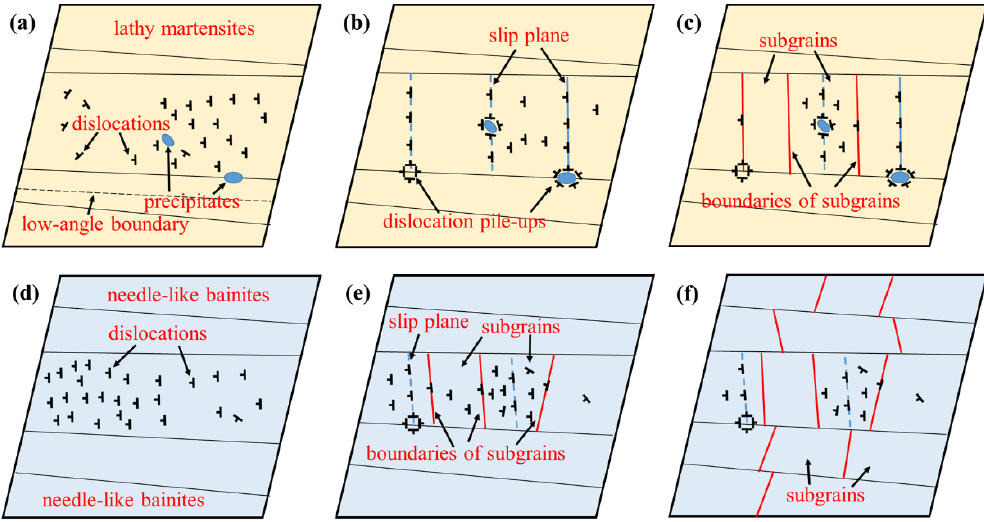
Figure 8. The schematic diagrams of the microstructural evolution mechanisms for martensites and bainites induced by LCF damage up to fracture: the as-received specimens ( a ), the LCF damaged specimens with the strain amplitudes of ±0.3% or ±0.5% ( b ) and ±0.8% ( c ) in BM; the as-received specimens ( d ), the damaged specimens with the strain amplitudes of ±0.3% or ±0.5% ( e ) and ±0.8% ( f ) in WM.